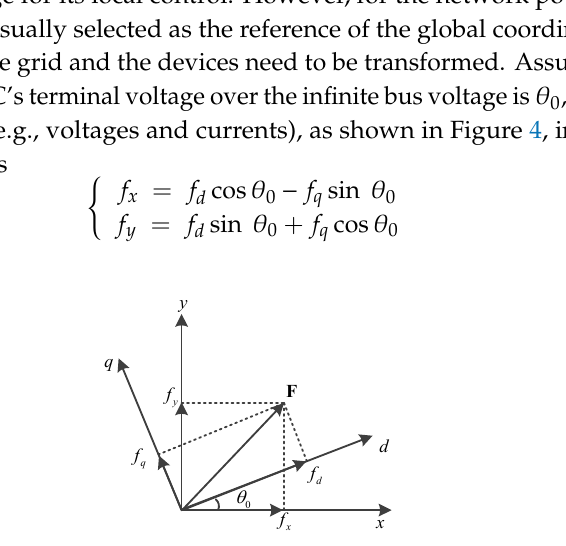
Figure 4. Transformation relations of a variable’s dq-components between the global frame and the local frame [15].